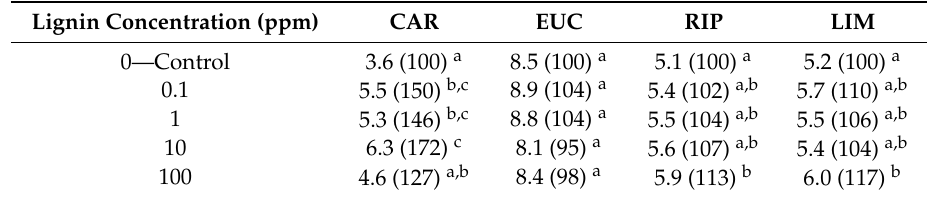
Table 5. Length (cm) of coleoptiles for maize seedlings treated with different concentrations (ppm) of CAR, EUC, RIP and LIM water-soluble lignins. Lignin Concentration (ppm) CAR